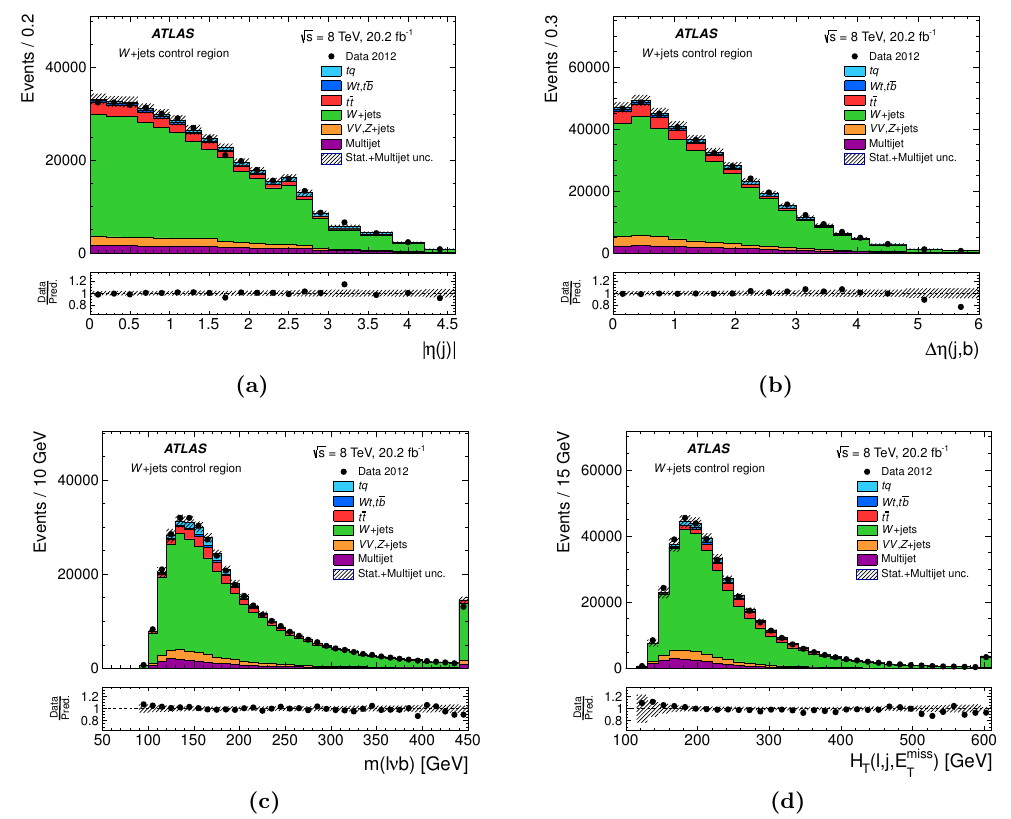
Figure 5. Distributions of the selection variables in the W +jets control region: (a) untagged jet, (b) separation in (cid:17) between the untagged and b -tagged jets, (c) reconstructed top- quark mass, and (d) scalar sum of the p T of the lepton, the p T of the jets and E miss